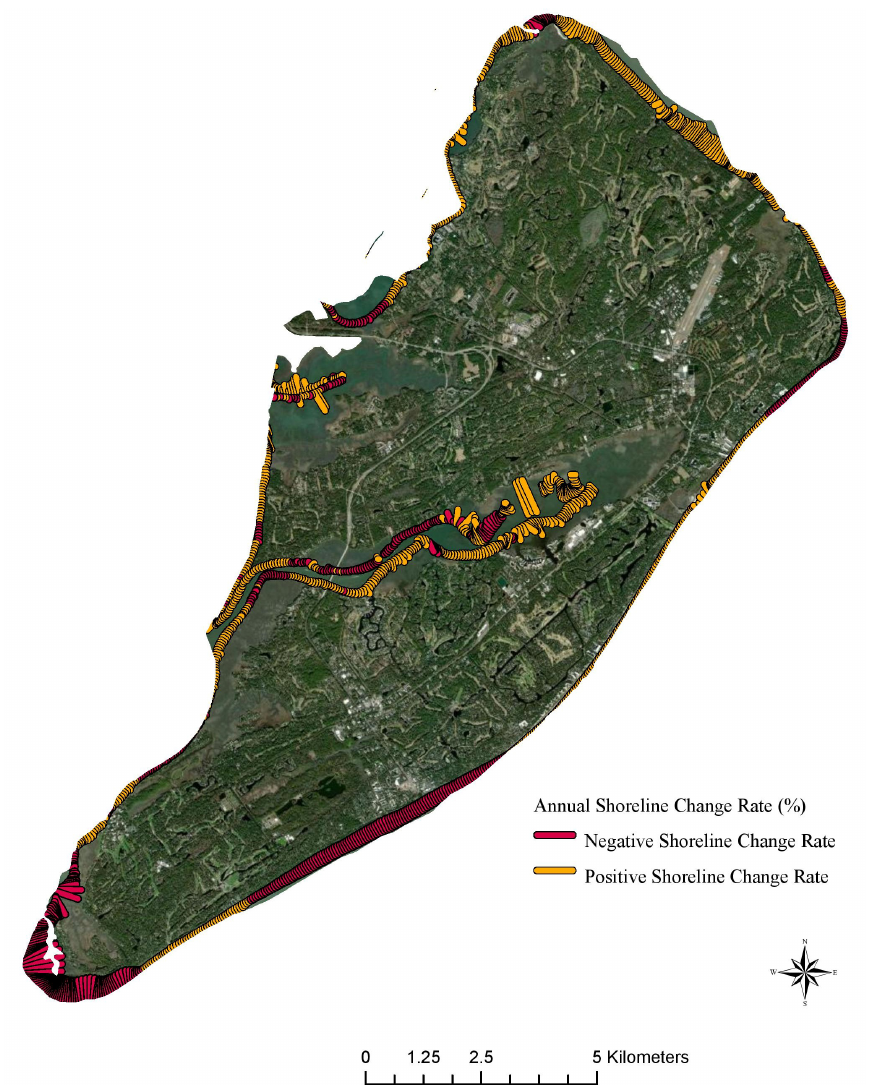
Figure 2. Annual shoreline change